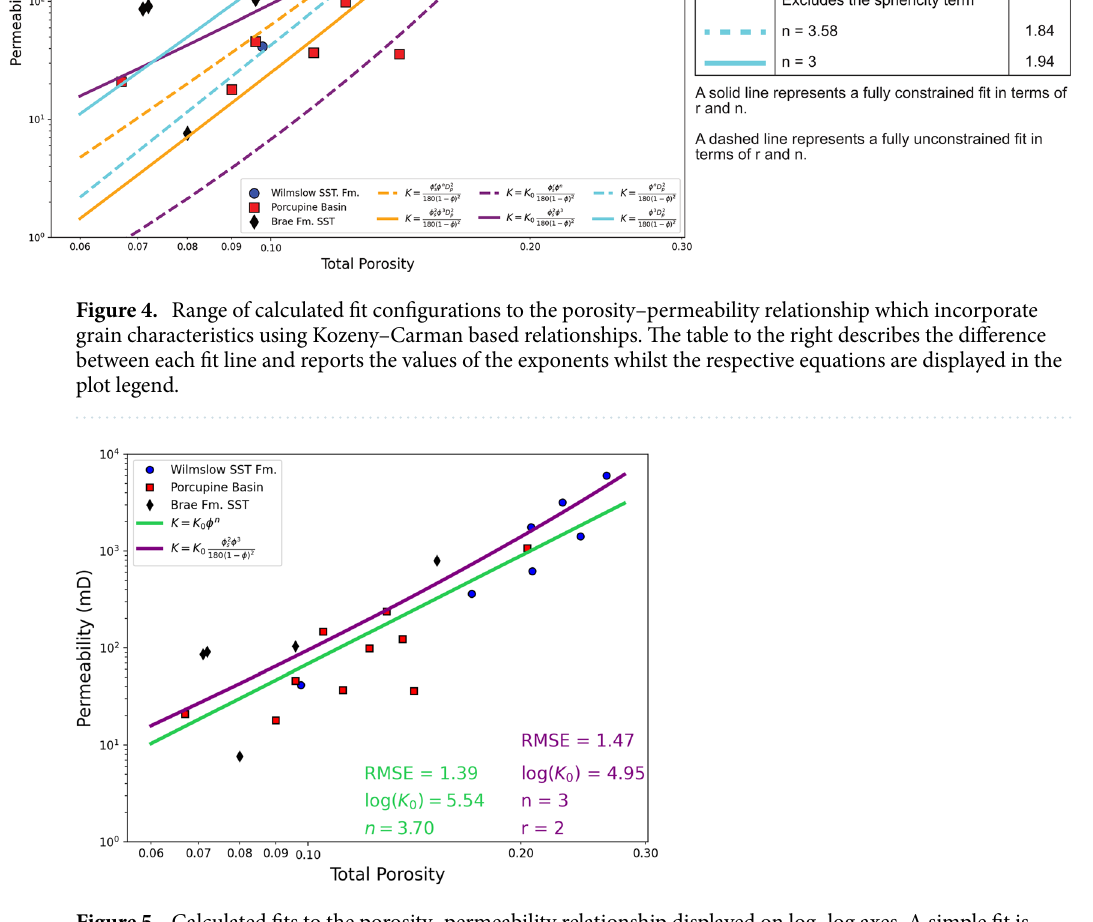
Figure 5. Calculated fits to the porosity–permeability relationship displayed on log–log axes. A simple fit is shown (green) alongside the most effective fit incorporating grain sphericity (purple) shown in Fig. 4. The root mean square error (RMSE) values are reported for each fit, showing that the better fit is the simpler one in green, excluding any grain